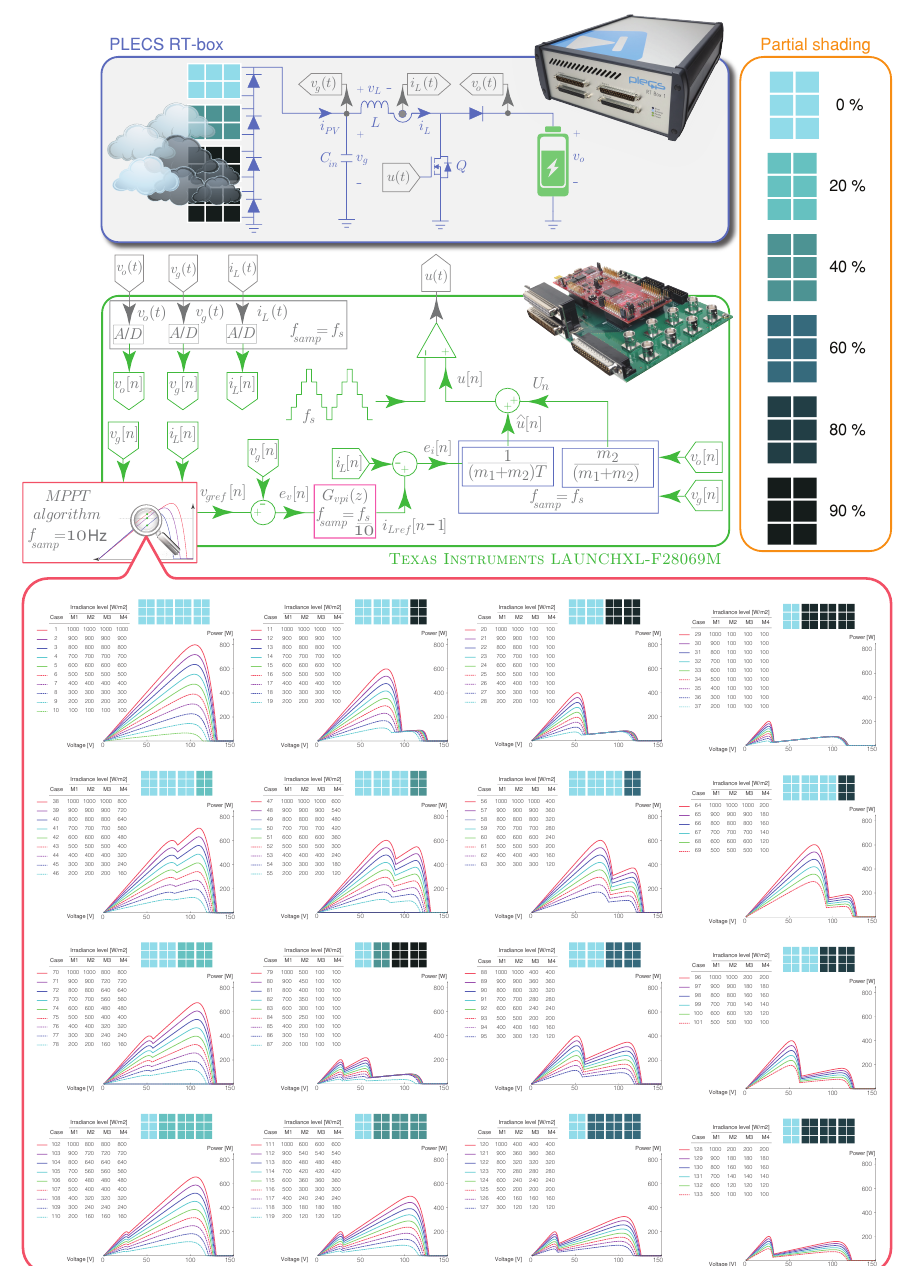
Figure 1. P-V characteristics of four PV module KC200GT under uniform and nonuniform irradiance conditions and connected in